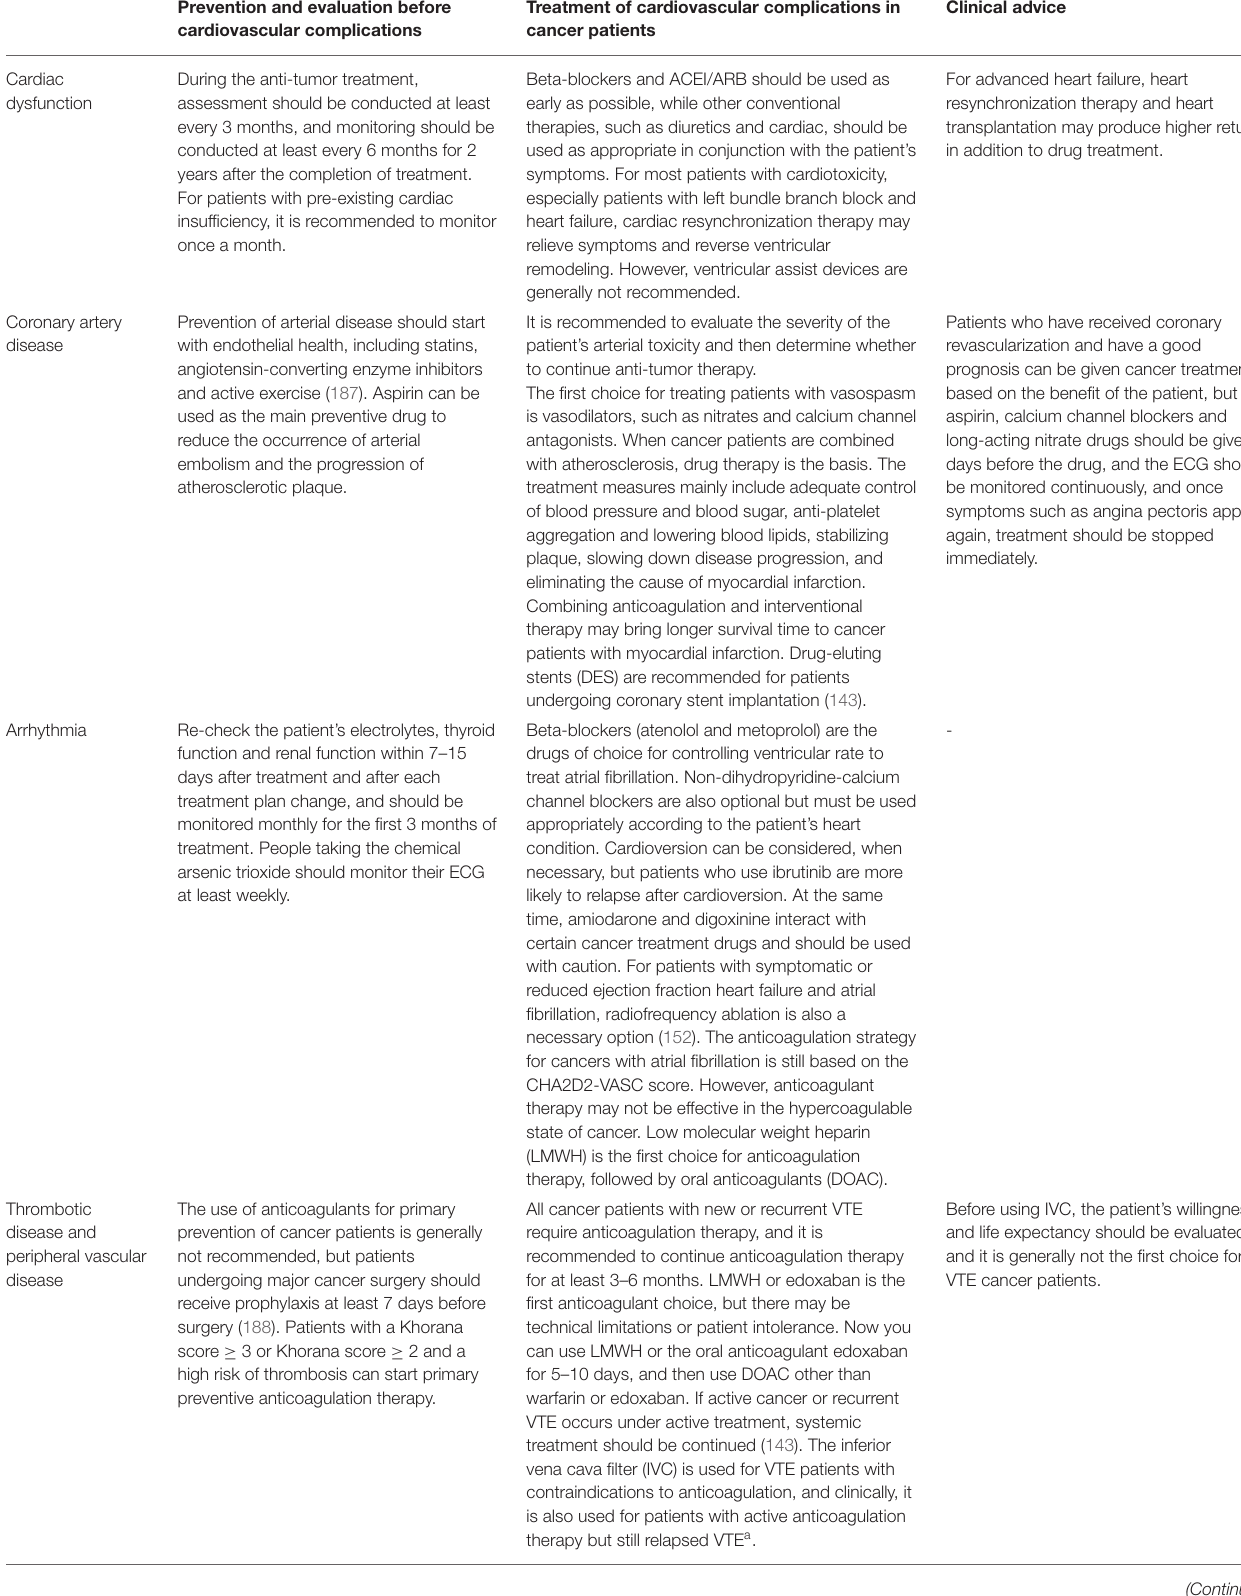
TABLE 4 | Prevention and treatment of cancer patients with cardiovascular